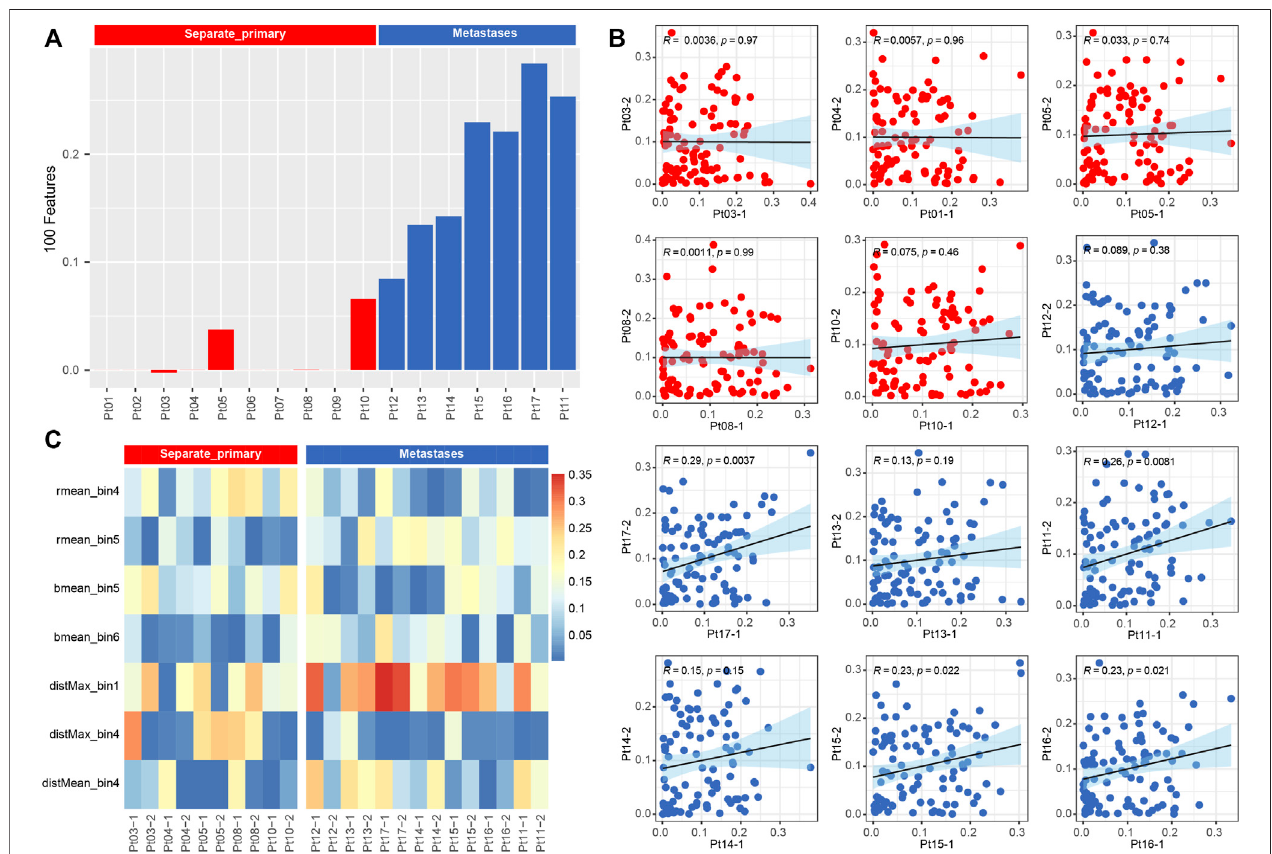
FIGURE 5 | (A) Barplot of correlation from all pathological image feature. (B) Boxplot of correlation from 15 types of pathological image feature.